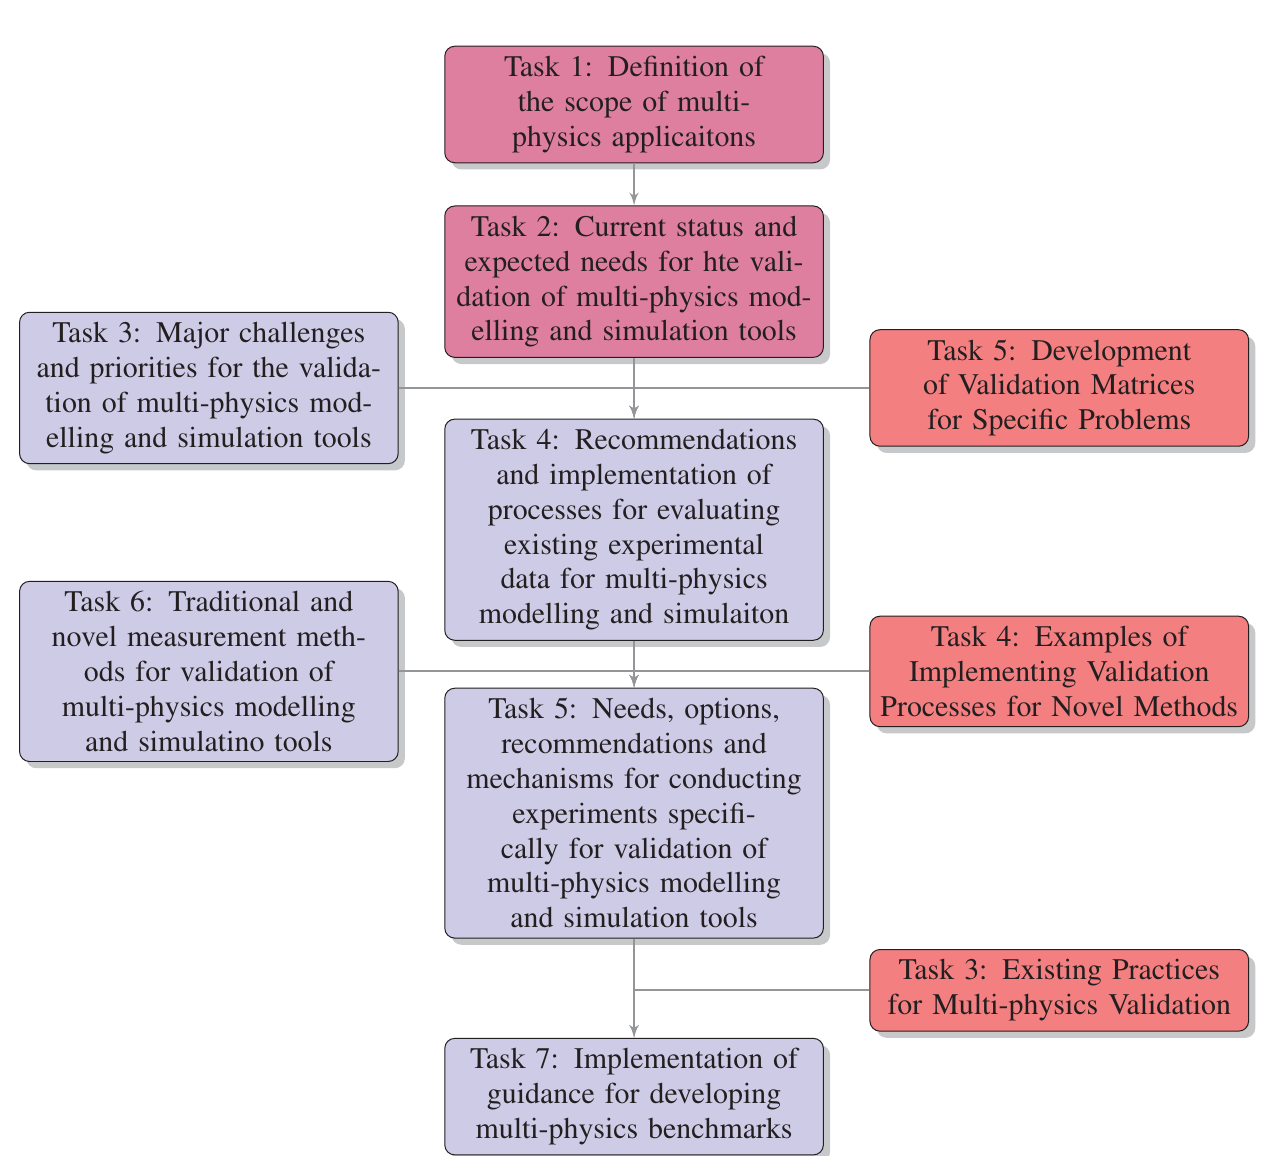
Figure 1: Organisation of the EGMPEBV Tasks within Task Force 1 (blue), Task Force 2 red) and those shared between the two (purple)